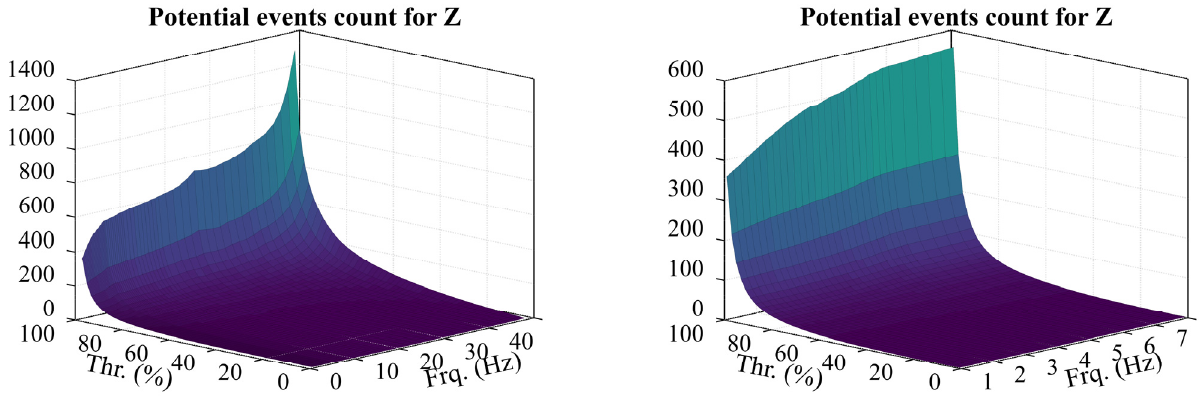
Figure 21. Quantities of potential impact events for different frequency ranges along the Z-axis.